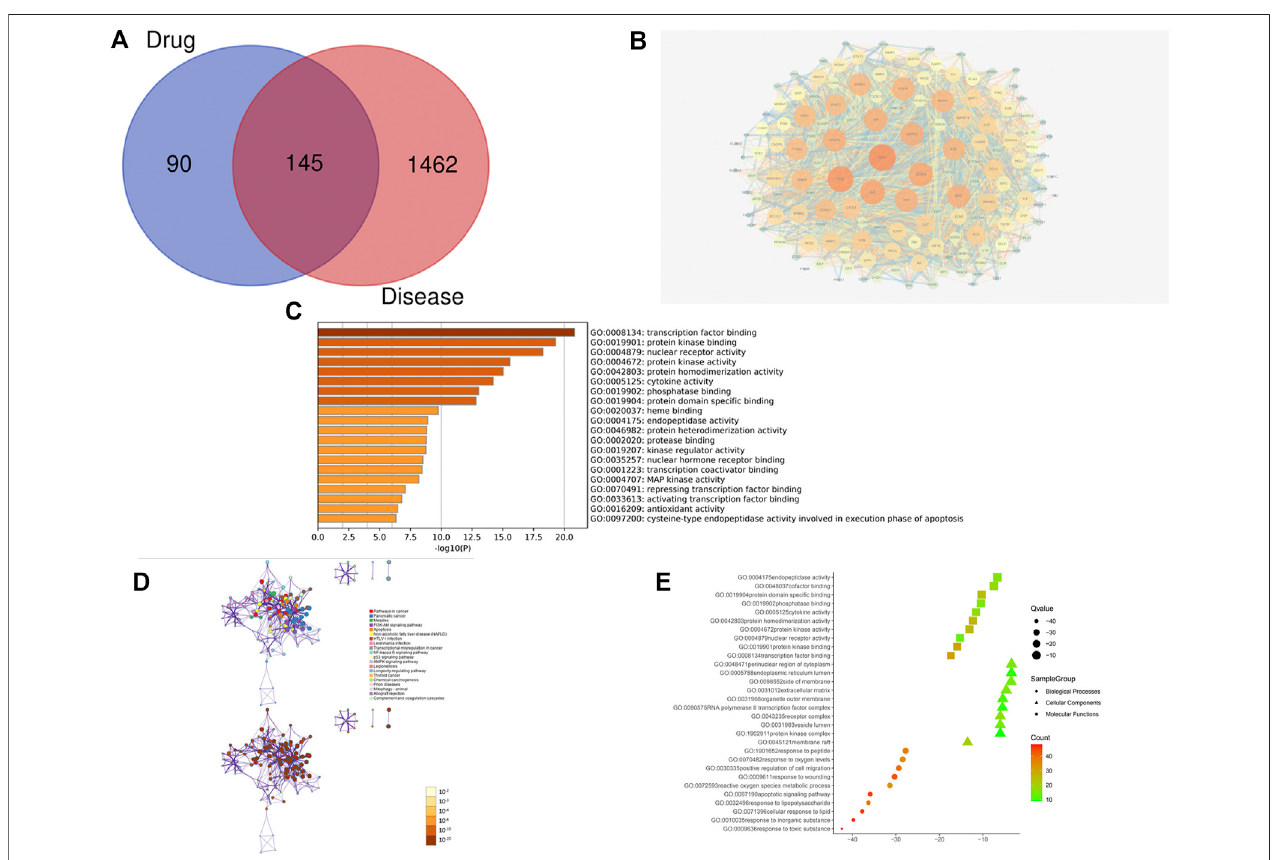
FIGURE 2 | Systems pharmacology model of ZZXJT. Notes: (A) : Intersection of ZZXJT predicted targets and liver cancer targets. (B) : PPI network of intersection target effect relationship. (C) : Main pathways in the systems pharmacology model. (D) : Distribution and signi fi cance of target proteins in pathway (C, E) : The further prediction and analysis of the target ’ BP, CC, and MF.